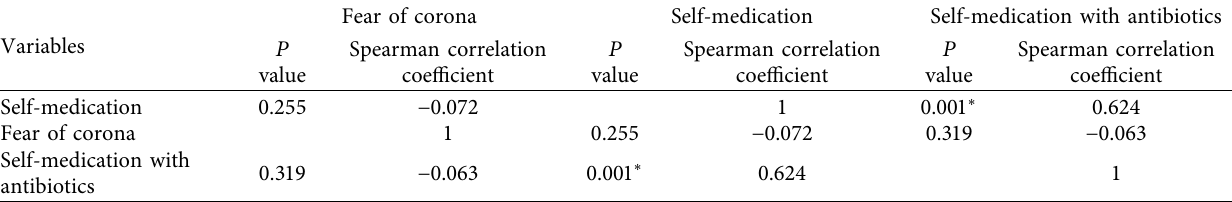
Table 5: Correlations between self-medication, fear of corona, and antibiotic